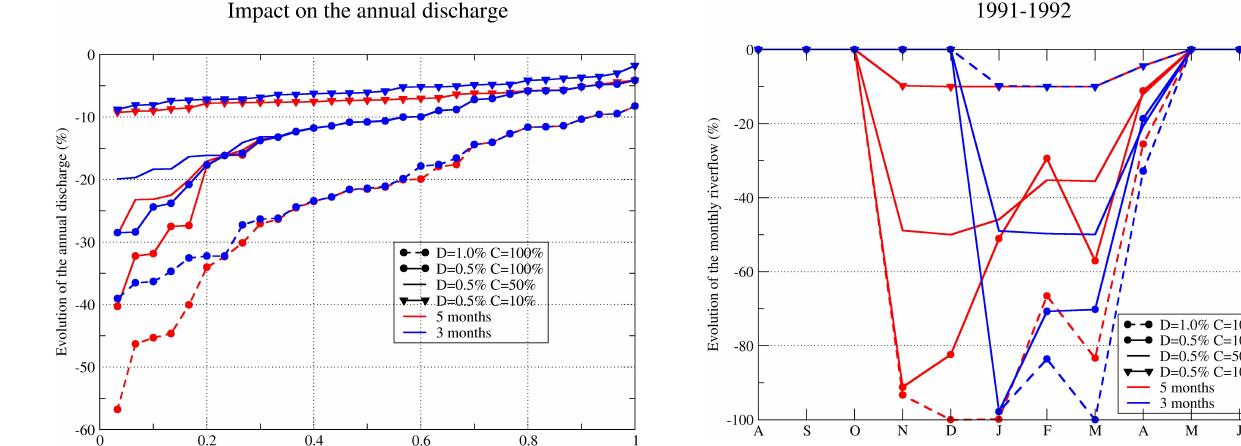
Figure 7. Impact of the small dams on the monthly river flows of the Layon River at St Lambert for the dry year